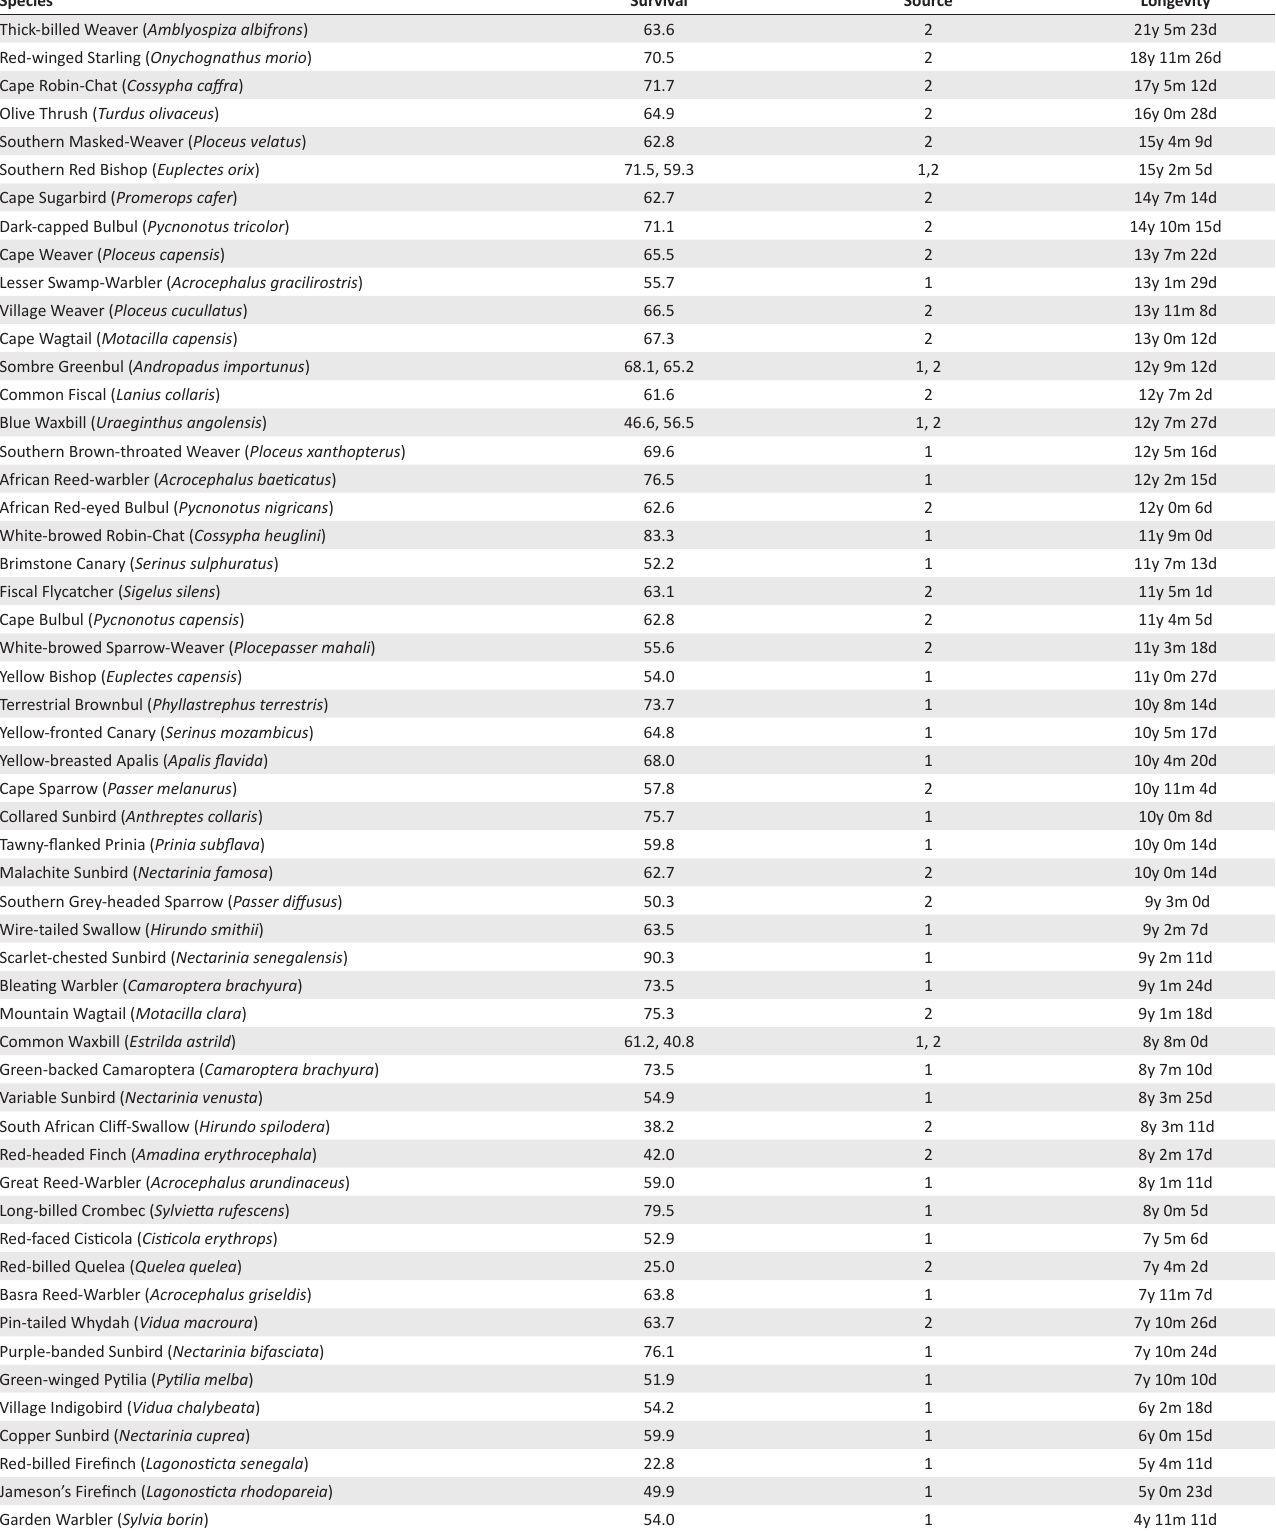
TABLE 2: Published annual survival estimates (as % ) compared to longevity records from this study.